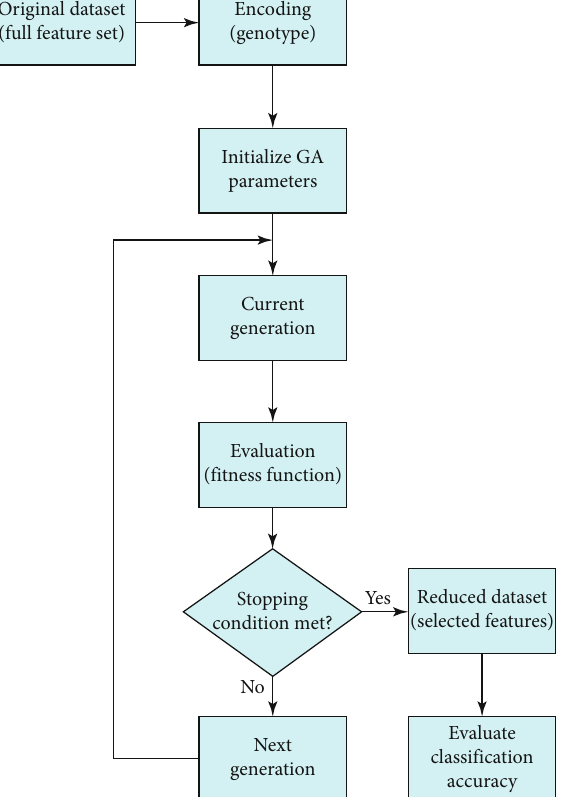
Figure 1: The proposed